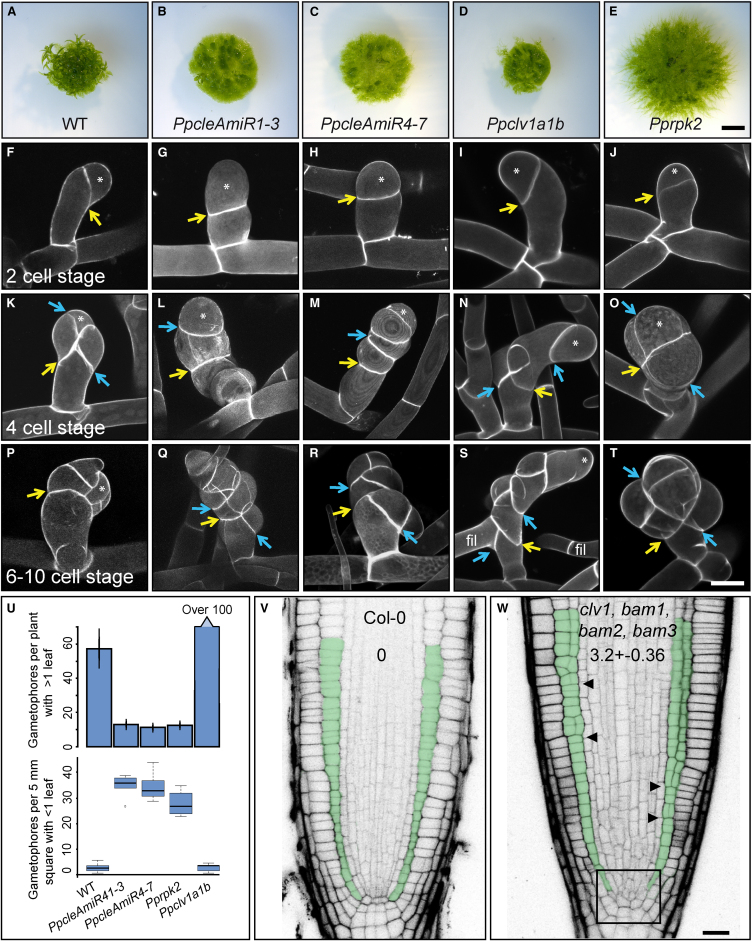
The CLV Pathway Regulates Cell Division Plane Orientations during 3D Growth in Physcomitrella and Arabidopsis(A–E) Although WT plants (A) developed many normal gametophores, PpcleAmiR1-3 (B), PpcleAmiR4-7 (C), Ppclv1a1b (D), and Pprpk2 (E) mutants had no obvious gametophores. The scale bar represents 0.35 cm.(F–T) PpcleAmiR1-3, PpcleAmiR4-7, Ppclv1a1b, and Pprpk2 mutants have cell division plane defects at the onset of 3D morphogenesis.(F–J) The first division of each bud is indicated by a yellow arrow and is set at a strongly oblique angle in WT (F), Ppclv1a1b (I), and Pprpk2 (J) plants, but is weakly oblique in PpcleAmiR1-3 (G) and PpcleAmiR4-7 (H) mutants.(K–O) Whereas (K) the second division (blue arrow) from the apical cell (asterisk) is normally oblique and roughly perpendicular to the first, in PpcleAmiR1-3 (L), PpcleAmiR4-7 (M) and Ppclv1a1b (N) mutants, it is roughly parallel to the first. Pprpk2 (O) mutants look normal at this stage.(P–T) The stereotypical divisions that normally generate the tetrahedral shape of the gametophore apical cell at the 6- to 10-celled stage of development (P) are misset in PpcleAmiR1-3 (Q), PpcleAmiR4-7 (R), and Ppclv1a1b (S), and Pprpk2 (T) mutants. The scale bar represents 30 μm.(U) Bar chart and boxplot showing that gametophore initiation was disrupted in PpcleAmiR1-3, PpcleAmiR4-7, PpCLV1a1b, and Pprpk2 mutants. The number of gametophores with >1 leaf was counted in 5 WT and mutant plants from a single line representing each mutant class. Gametophore buds with <1 leaf were counted from a 5-mm2 area in 3 WT and mutant plants from a single line representing each mutant class. ANOVA, Tukey’s Honest Significant Difference (HSD) test; p < 0.005.(V and W) Confocal micrographs of WT (Col-0) (V) and clv1/bam1/bam2/bam3 mutant (W) root tips showing disordered cell division plane orientations in the meristem and ground tissue layers. The box in (W) indicates the meristem, and arrowheads indicate the developmental onset of abnormal periclinal division plane orientations in the cortex layer (shaded green). The scale bar represents 20 μm.See also Figure S6, Methods S1, and Table S4.